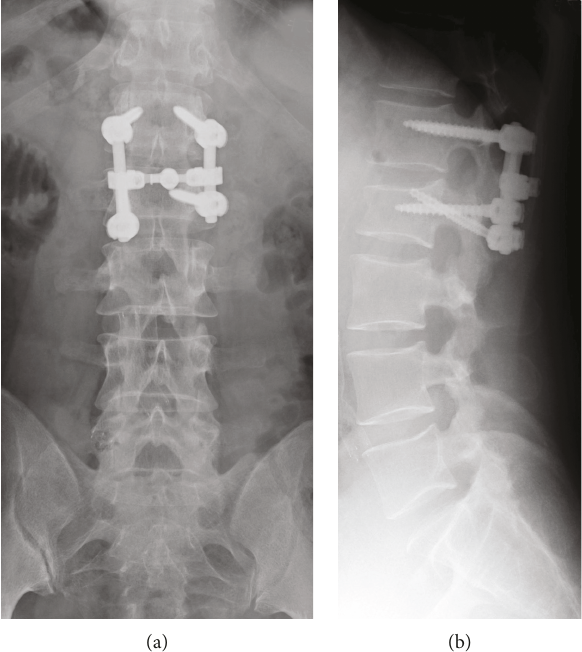
Figure 3: Postoperative plain X-rays of the lumbar spine. (a) Anteroposterior and (b) lateral radiographs show an L1-L2 single- level instrumented fusion using a CBT pedicle screw for L2 on the left